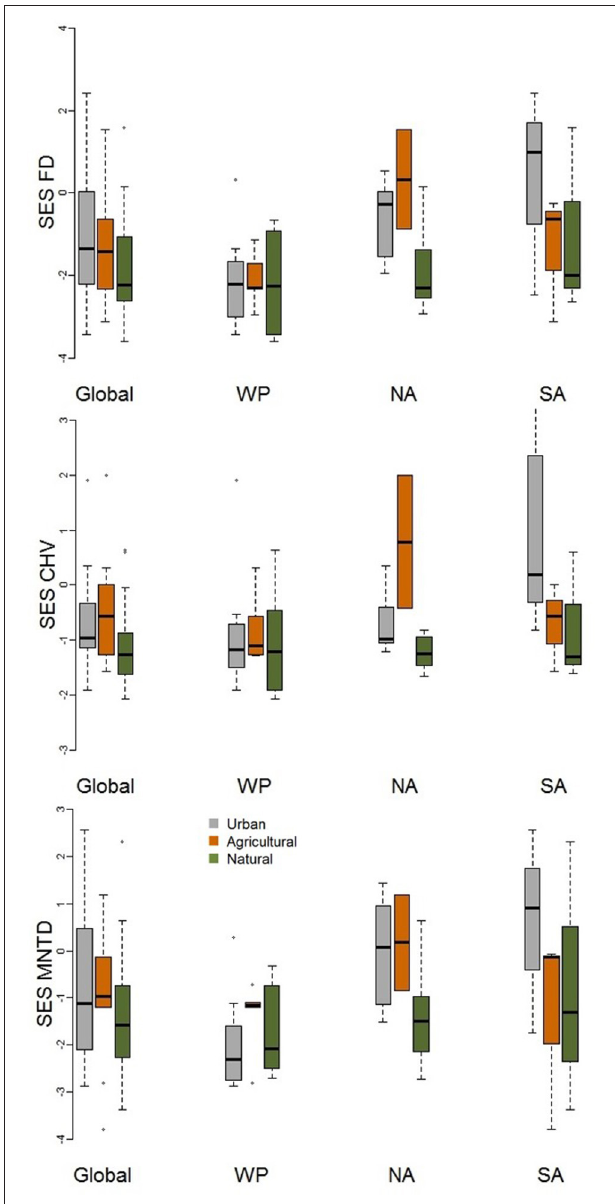
FIGURE 5 | Boxplot comparing standardized effect size functional diversity metrics (FD, MNTD, and CHV) that take species richness into account for urban avian assemblages and their paired natural and agricultural assemblages at the global scale and for the Western Palearctic (WP), North America (NA), and South America (SA). See Table 2 for statistical